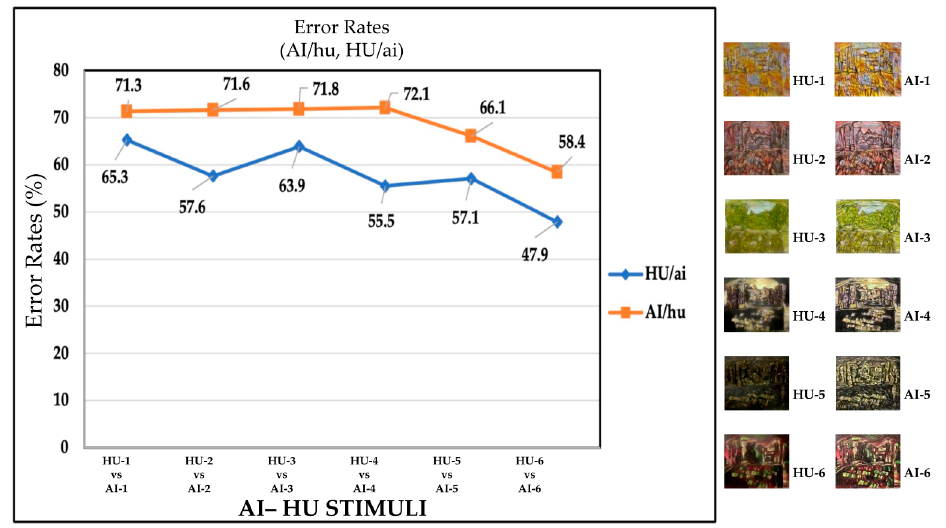
Figure 5. The corresponding error (misidentification)